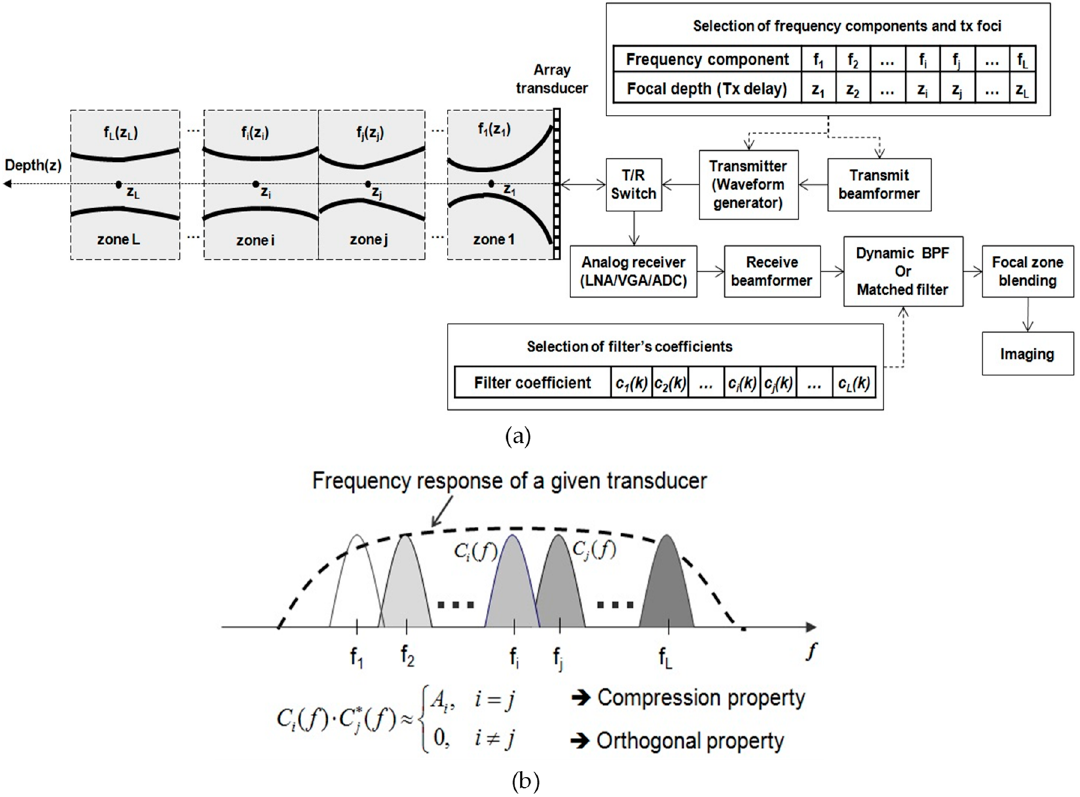
Figure 1. System block diagram of STMF method using frequency divided sub-band signals. ( a ) Illustration of the improvement of lateral beampattern; ( b ) design strategy of frequency band divided signals to have both compression and orthogonal property.